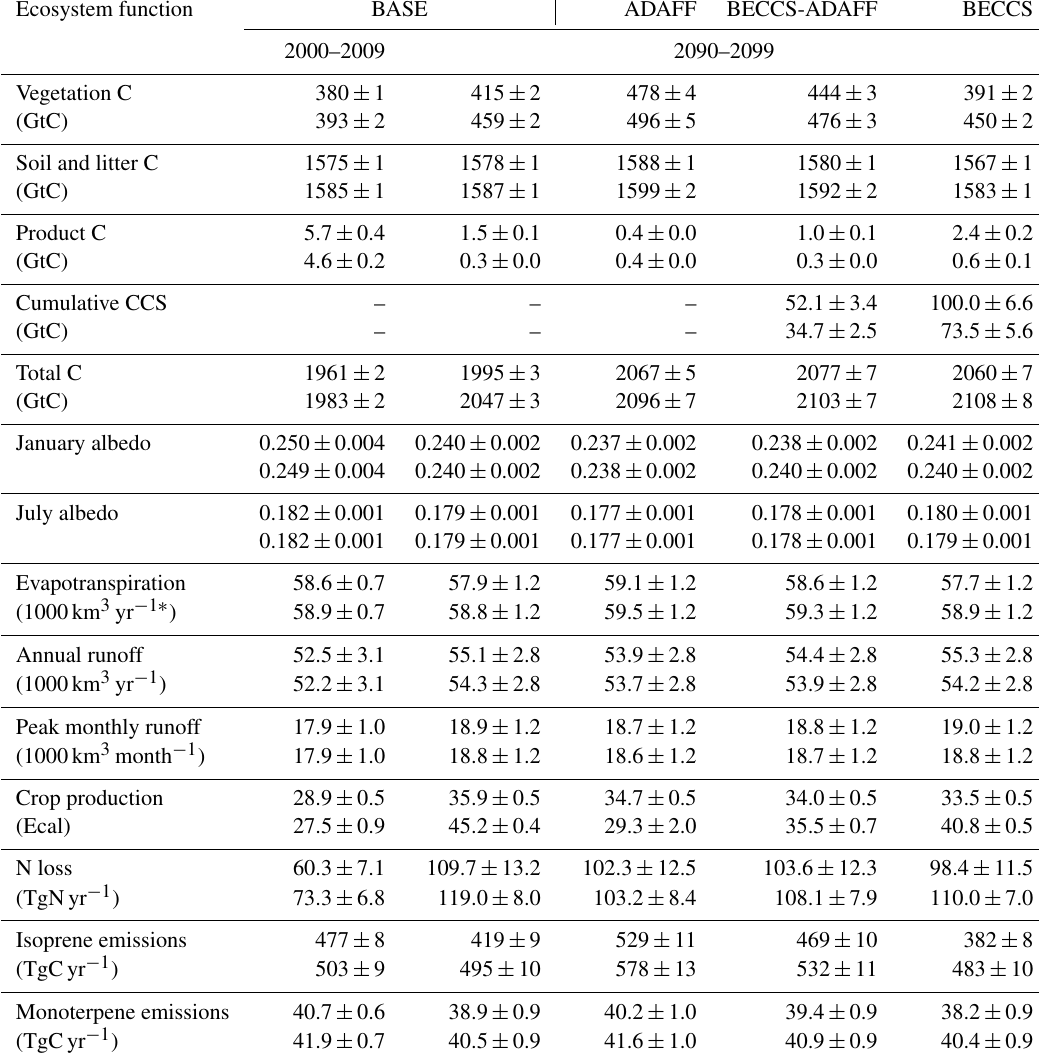
Table 2. Global net-total values ± standard deviations (over 10 years) of all analysed ecosystem functions as simulated by LPJ-GUESS for all scenarios and different time periods and for LPJG IMAGE (top) and LPJG MAgPIE (bottom). Total C is the sum of vegetation C, soil C, product C (wood removed during deforestation but not immediately oxidized), and cumulative